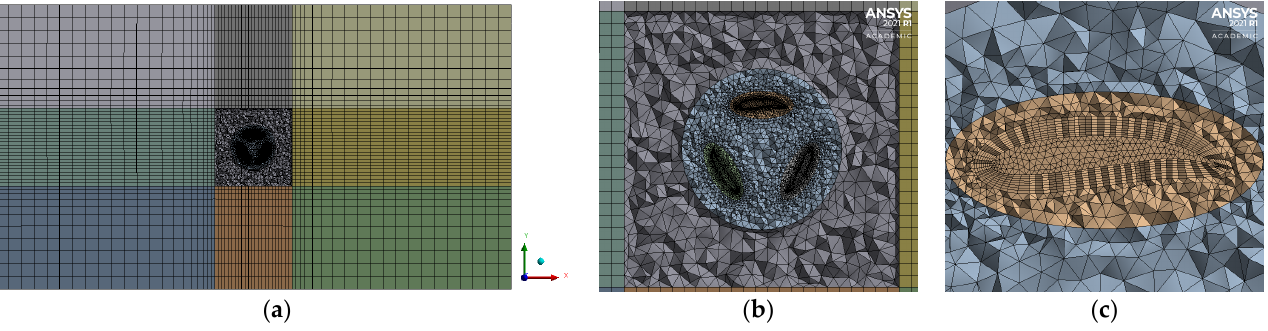
Figure 4. Cross-section of 1.4 million element mesh for Darrieus VAWT: ( a ) Full mesh; ( b ) Close-up of mesh centre; ( c ) Close-up of mesh around a blade. All the configurations used the same setup values (Table 3), with some values changed to match the parameters of the current simulation. The simulations were performed with